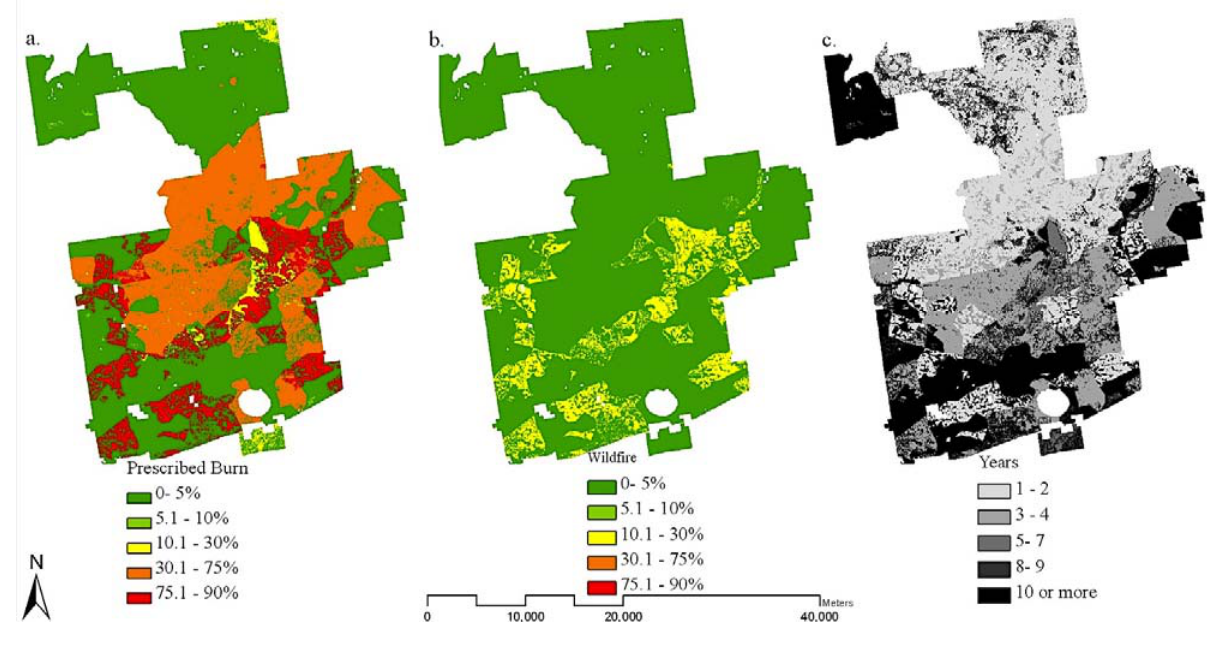
Figure 5. Model derived probability of high burn severity for ( a ) prescribed burns; ( b ) wildfires; and ( c ) time since last fire across the entire Osceola National Forest,